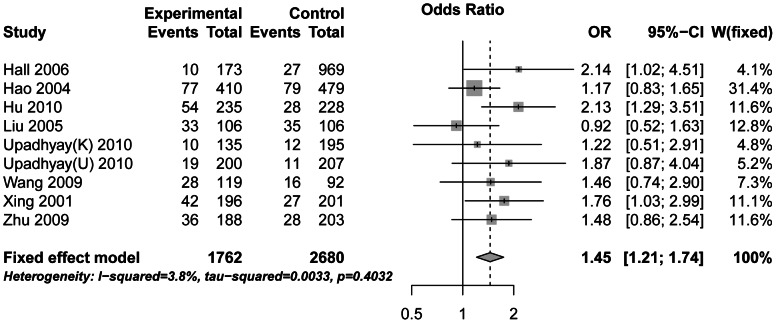
Forest plots result without the study of Li et al.The center of each square represents the OR, the area of the square is the weight used in the meta-analysis, and the horizontal line indicates the 95% CI.